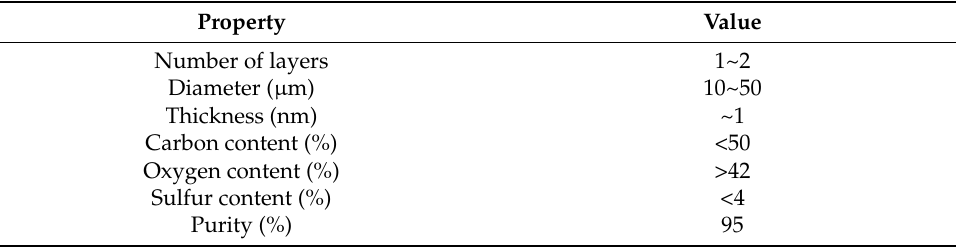
Table 2. Overview of graphene oxide